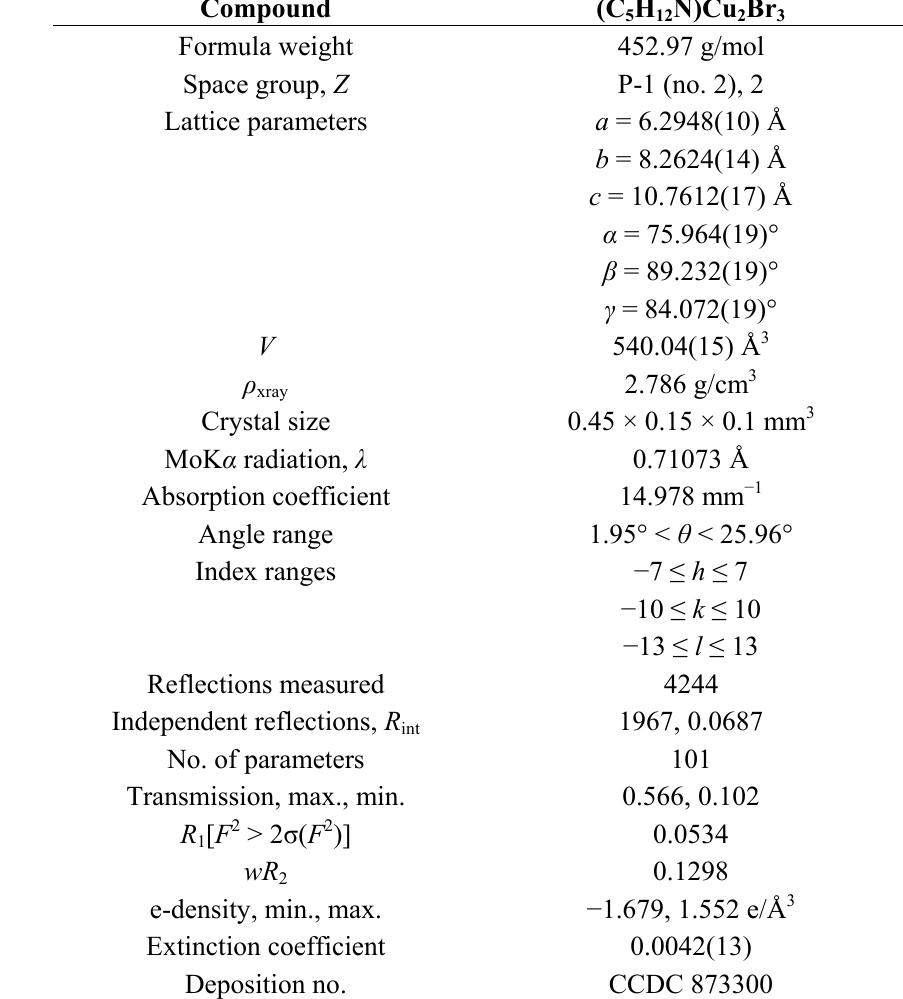
Table 1. Crystal data, data collection, and refinement details at 173 K.